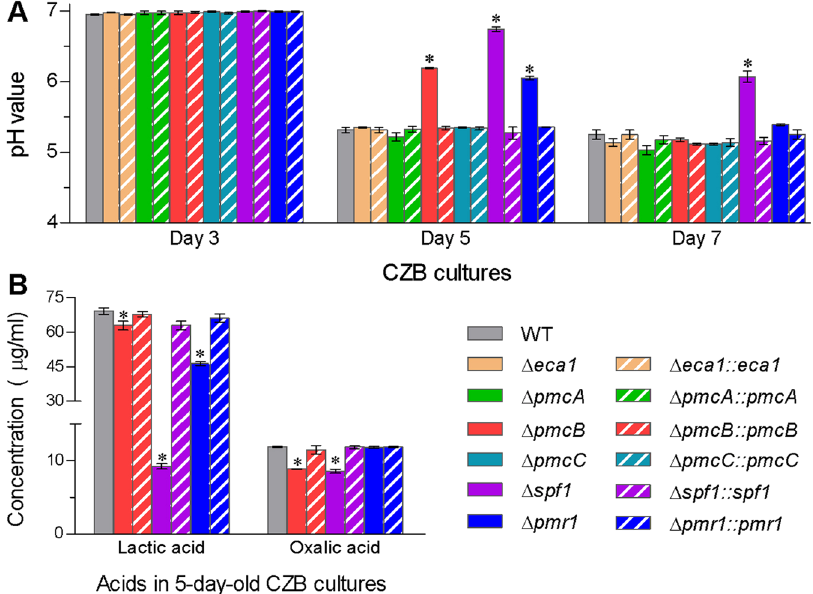
Figure 3. The CA pumps sustaining extracellular pH levels in B . bassiana . ( A , B ) pH levels measured from the supernatants of liquid cultures of different strains during incubation in minimal CZB (initial pH = 7.3) and concentrations of lactic acid and oxalic acid quantified from the supernatants of 5-day-old CZB cultures, respectively. The asterisked bars in each bar group differ significantly from those unmarked (Tukey’s HSD, P < 0.05). Error bars: SD from three